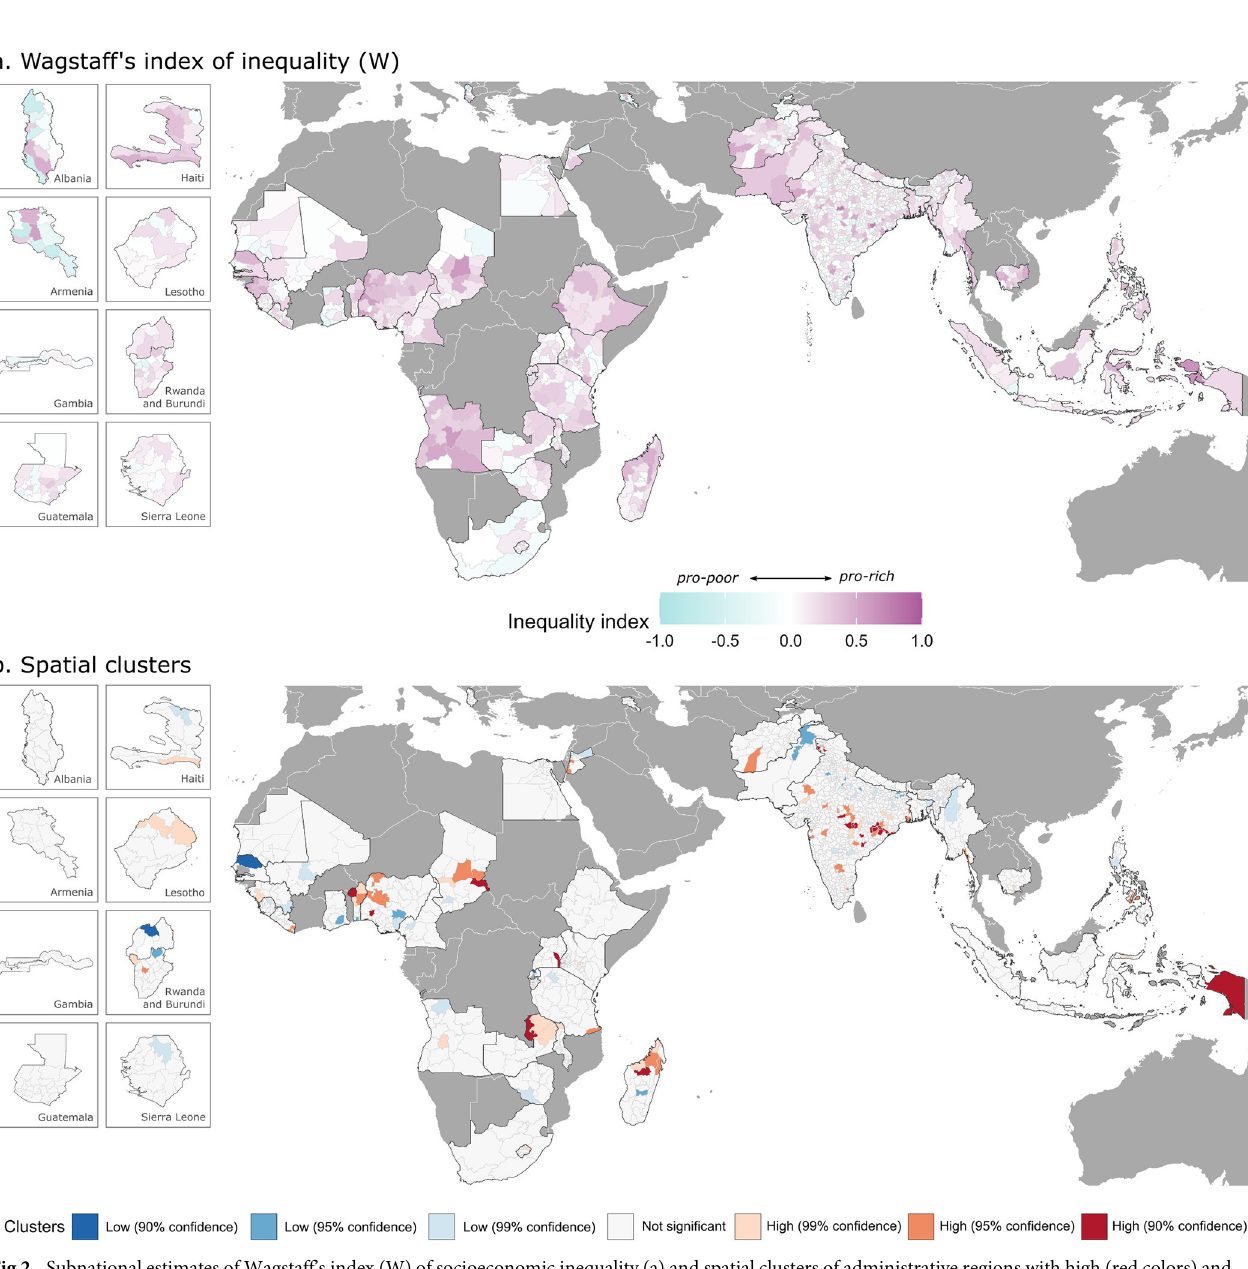
PLOS Medicine| https://doi.org/10.1371/journal.pmed.1004166 January 17,